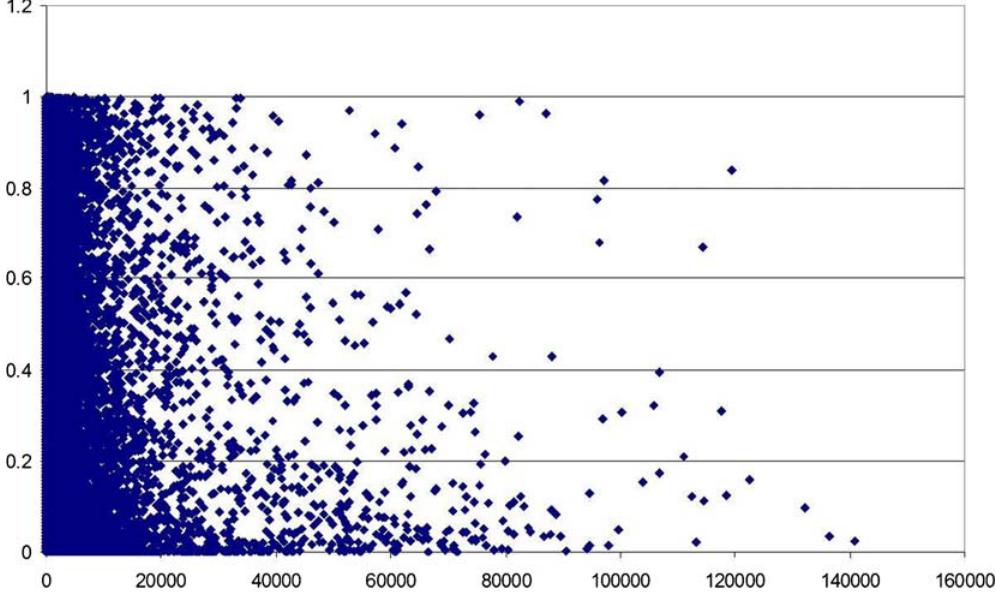
Figure 2. A scatter plot of mean intensity (axis X) and likeliness of periodicity estimated by Pt-test p-value (axis Y).